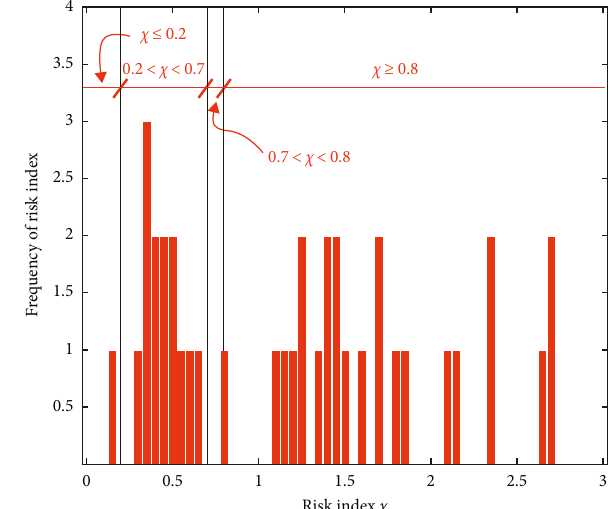
Figure 10: Histogram of vulnerability indices of buildings with χ i <